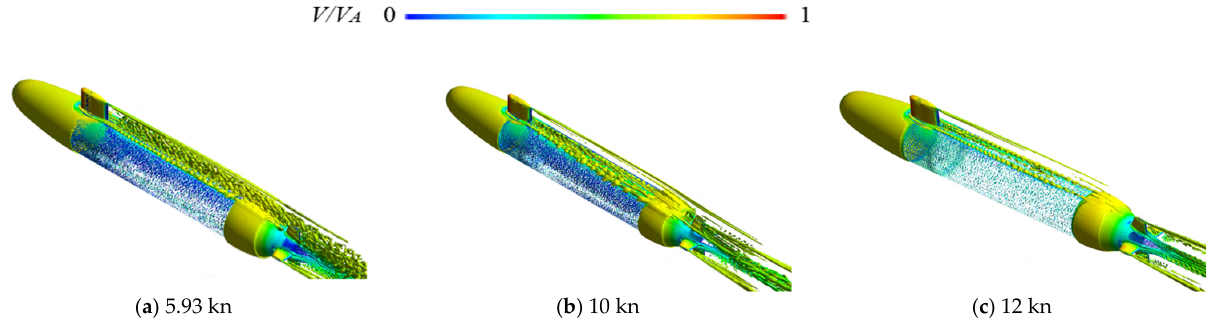
Figure 7. The instantaneous isosurface of the Q-criterion at three velocities. Table 2. The drag and structural parameters of the horseshoe vortex at three velocities. Velocity (kn)